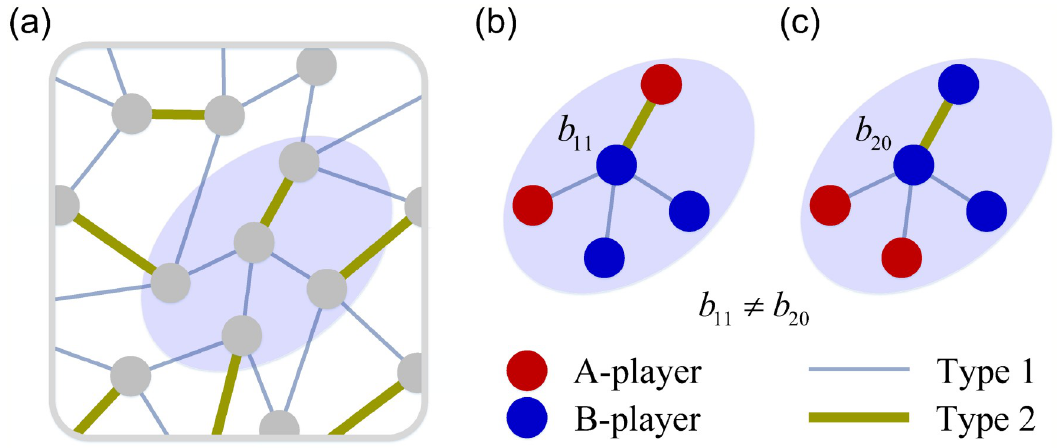
Fig 1. Illustration of evolutionary multiplayer games on graphs with edge diversity. (a) The population structure is depicted by a regular graph, where each node has k = 4 neighbors connected by two types of edges. In detail, in a typical neighborhood (the highlighted zone), the focal (i.e., centered) node has g 1 = 3 edges of type 1 (thin blue lines) and g 2 = 1 edge of type 2 (thick olive line). On the graph, each node is occupied by an individual. The focal individual’s payoff is determined by the state of its neighborhood, including its own strategy, all its neighbors’ strategies and the types of edges. This is different from traditional models about multiplayer games on graphs where edges are not distinguished and individuals’ payoffs are solely determined by strategies [22, 33]. We illustrate this difference by two concrete examples in subgraph (b) and (c). (b) Interacting with an A-player (red circle) and two B-players (blue circle) linked by edges of type 1, and an A-player linked by an edge of type 2, the focal B-player gains a payoff b 11 . (c) Interacting with two A-players and a B-player linked by edges of type 1, and a B-player linked by an edge of type 2, the focal B-player obtains a payoff b 20 . In our model, b 11 in general differs from b 20 , which is in stark contrast with the case where no edge diversity is present. In the latter case, b 11 = b 20 since the total number of neighboring A-players is the same. https://doi.org/10.1371/journal.pcbi.1006947.g001 probability that a single A-player starting in a random position propagates and takes over the is the probability that a single B-player starting whole population of B-players. Analogously, ρ B in a random position propagates and takes over the whole population of A-players. Natural selection favors strategy A over B if r > r : A B Using weak selection, in large random regular graphs with n edge types ( k � 3 and 1 � g i � k ), we obtain the condition under which A-players are selected over B-players (see S1 File, Section 1), given by